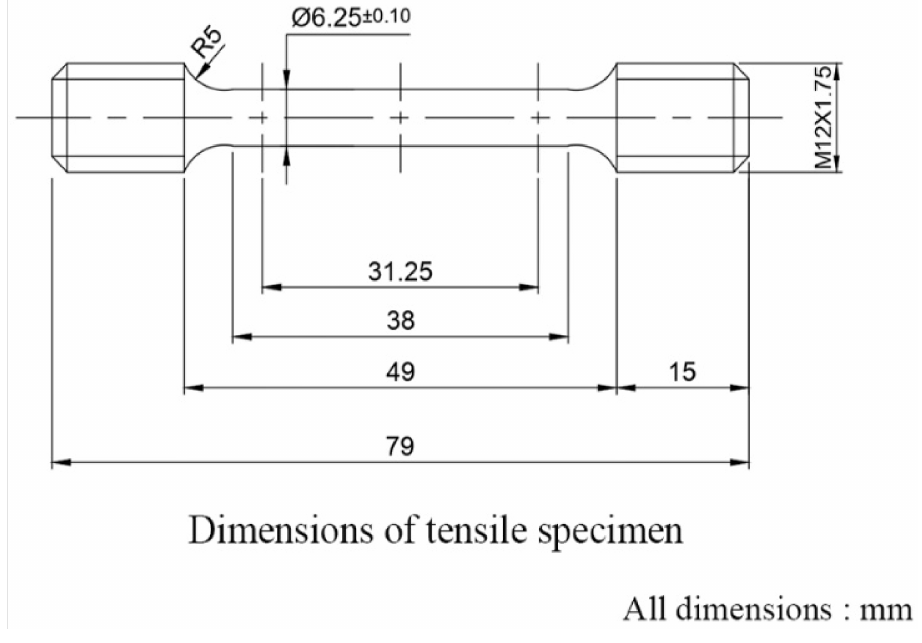
Figure 2. Tensile test specimen geometry.